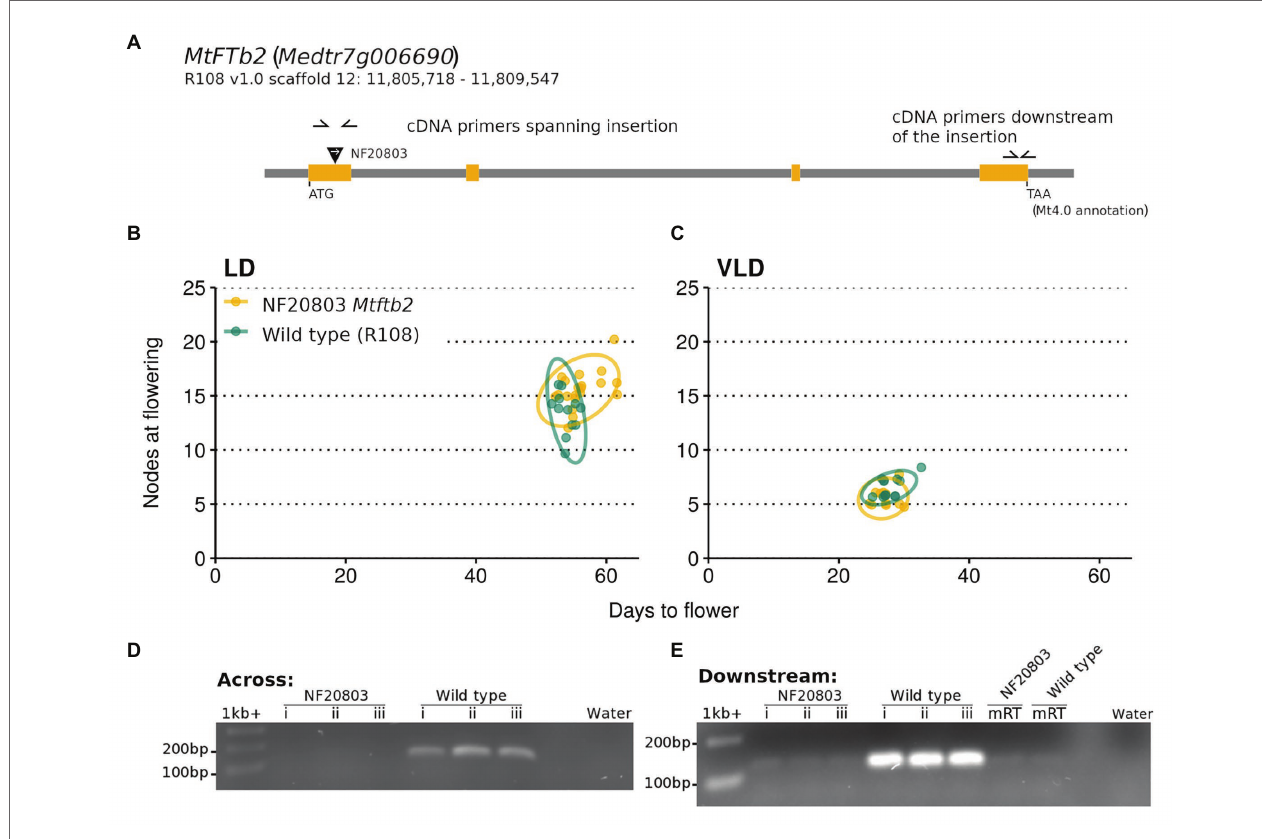
FIGURE 7 | The NF20803 Mtftb2 mutant flowers at a similar time to wild type R108. (A) is a schematic of the MtFTb2 (Medtr7g006690) locus with the exons depicted in orange. The inverted black triangle indicates the location of the NF20803 Tnt1 insertion and the white arrow denotes the orientation of the insertion. Primers used are indicated as half arrows. The flowering time of M. truncatula NF20803 Mtftb2 mutants ( n = 11–20) grown in (B) LD and (C) VLD are plotted below. Flowering time graphs are plots of days to flower against nodes on the primary axis at the time of flowering. Each point represents an individual plant. Variation is indicated by 95% confidence ellipses. Below are gels that depict the lack of amplification of the MtFTb gene in cDNA from the mutant compared to wild type R108 plants. Reactions in (D) used primers which span the Tnt1 insertion and (E) used primers which are downstream of the